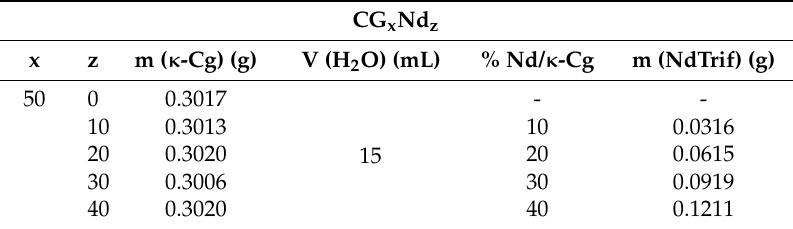
Table 2. Relevant details of the CG x Nd z